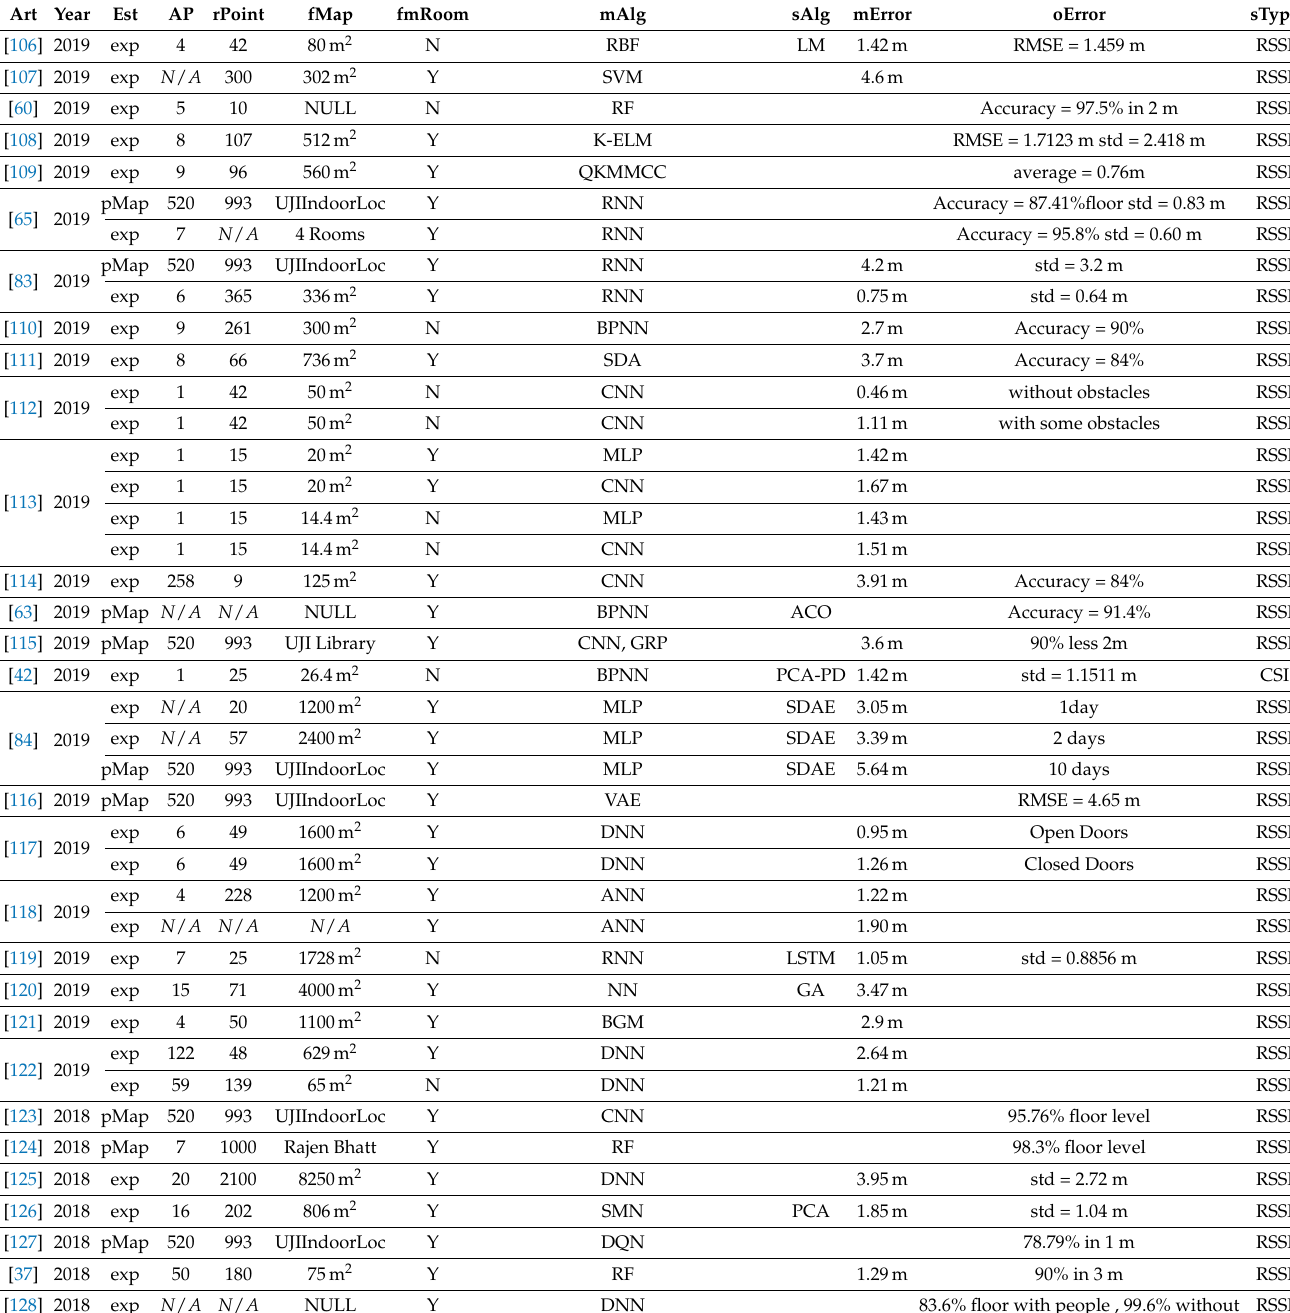
Table A3. Summary of reviewed